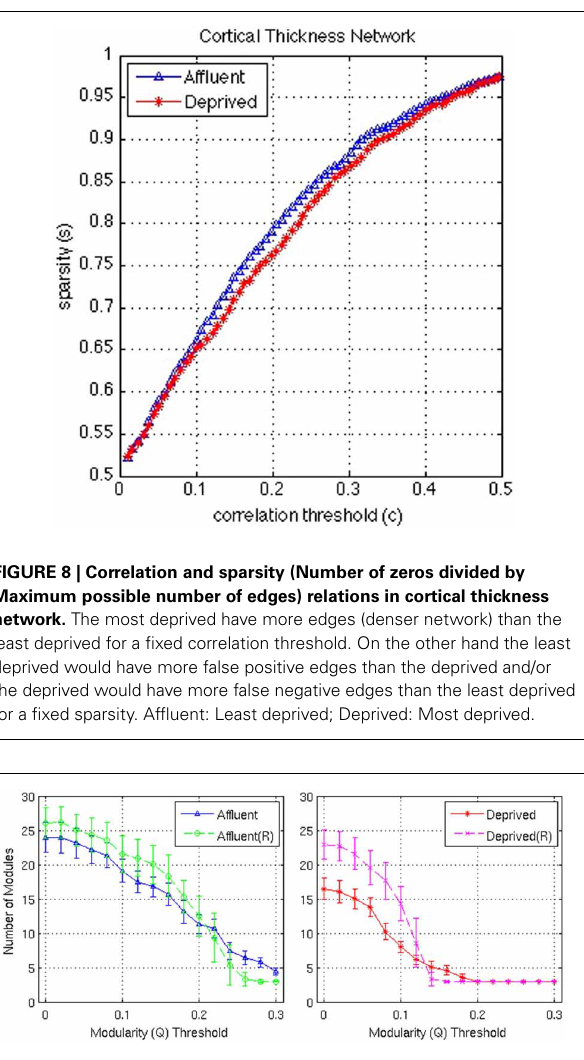
FIGURE 9 | Number of modules and the corresponding random graphs [indicated by “(R)”] with respect to various modularity ( Q ) threshold. Error bars represent the 1 σ -bound for each case. In the module calculation algorithm, if the module contribution, Q or (cid:2) Q , is less than the threshold, it was declared indivisible. Higher thresholds imply strong modules. Affluent: Least deprived; Deprived: Most